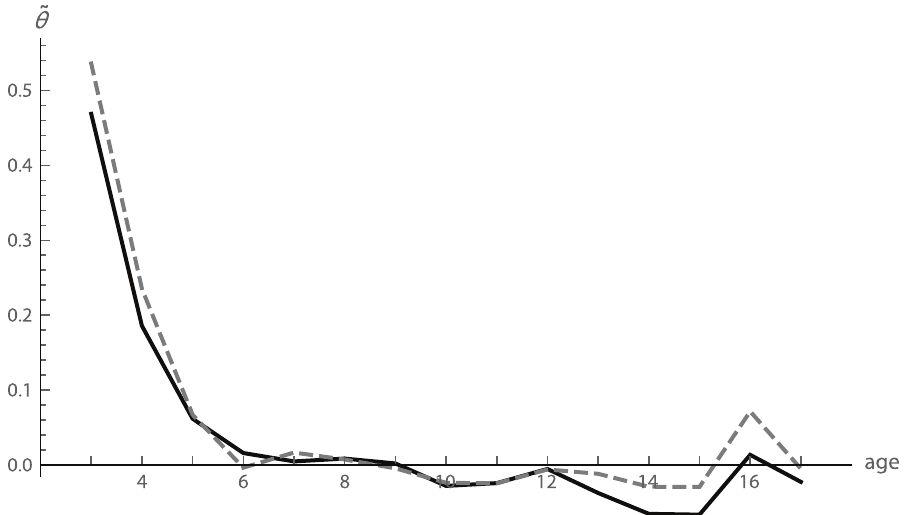
Fig 5. Strength of canalization in craniofacial size. The estimated strength of canalization, ~ y � and after removing sexual dimorphism (solid and dashed lines, respectively).